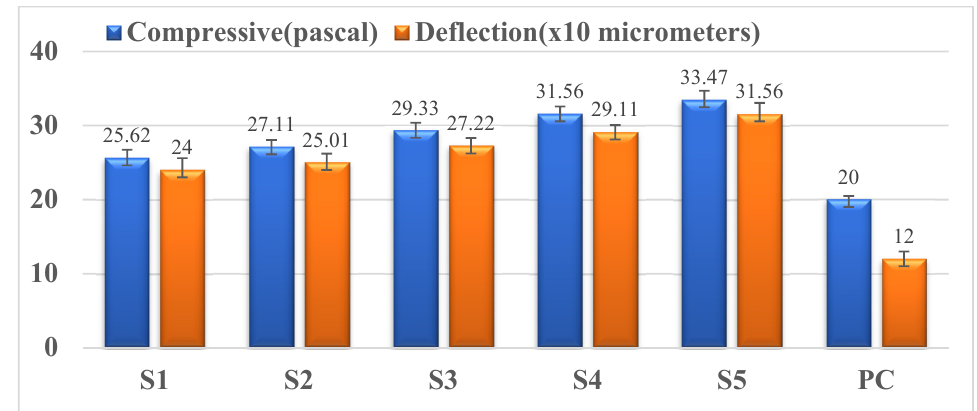
Figure 6. Variation of strength v/s deflection in compression.